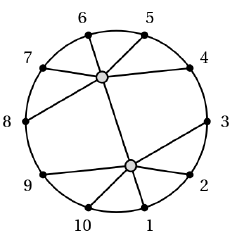
Figure 2 . Example of an OG forest of type 5 with strand permutation (1 6)(2 9)(3 10)(4 7)(5 8)